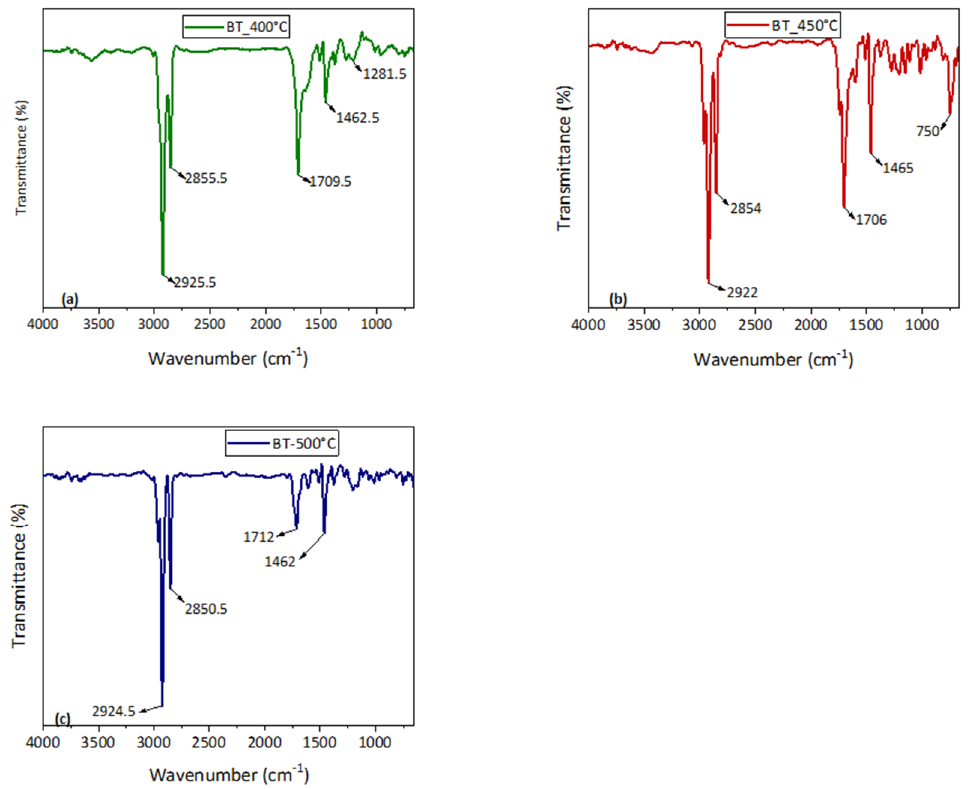
Figure 6. FTIR spectra of the bio-oils from teff husk slow pyrolysis at (a) at 400 ℃ (b) 450 ℃, (c) 500 ℃ .